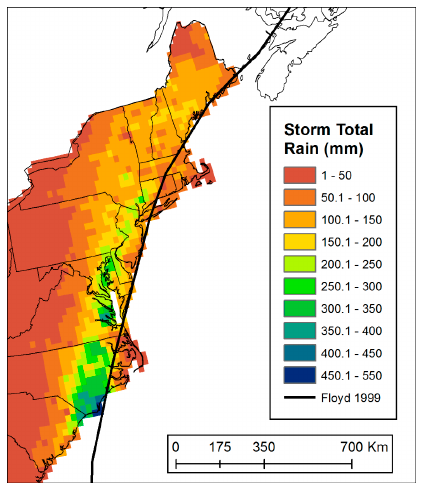
Figure 5. Storm total rainfall (mm) for Floyd (1999).